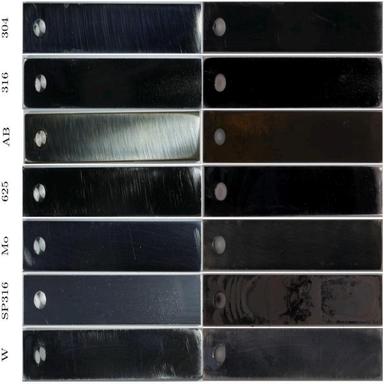
Sample images of one large sample for each material tested before (left) and after (right) lithium exposure. Most materials are relatively unaffected by lithium exposure. The structural materials show no change in their surface appearance. The refractory metals show some discoloration and appear less reflective. The bolt materials (aluminum-bronze and silver-plated 316 stainless steel) are attacked extensively by the lithium.